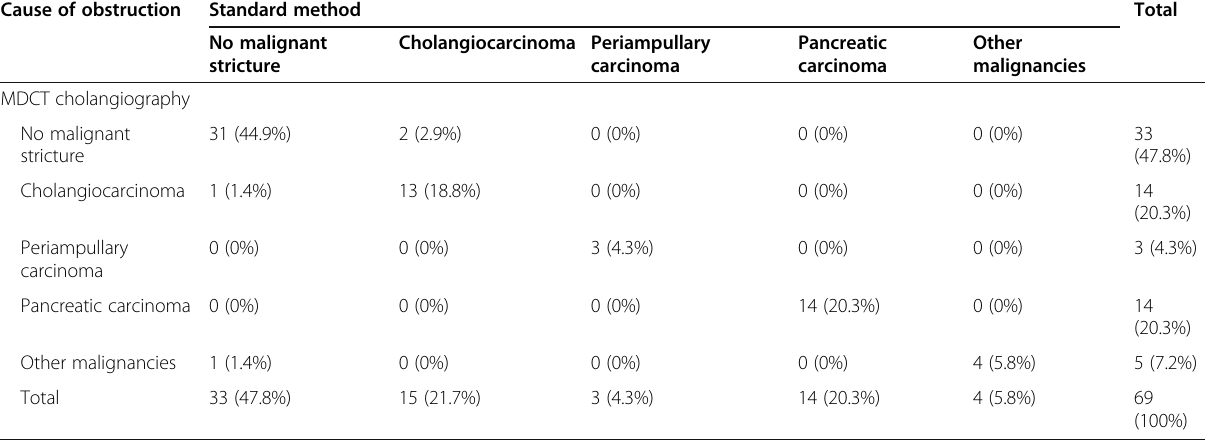
Table 7 Agreement between MDCT cholangiography and gold standard method in the detection of malignant lesion type Cause of